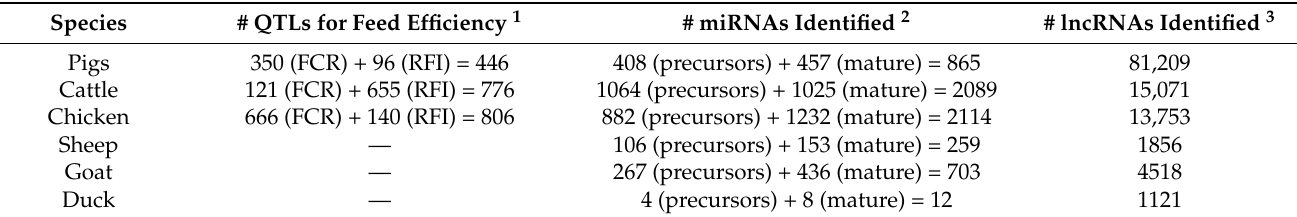
Table 1. Number of miRNAs and lncRNAs in livestock